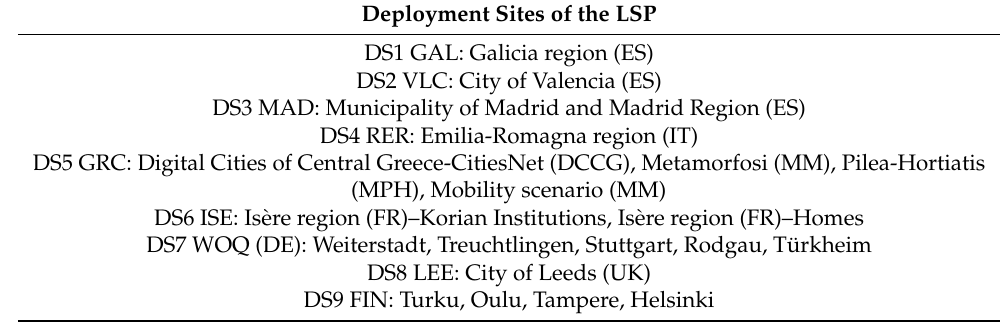
Table 1. Deployment sites of the LSP.